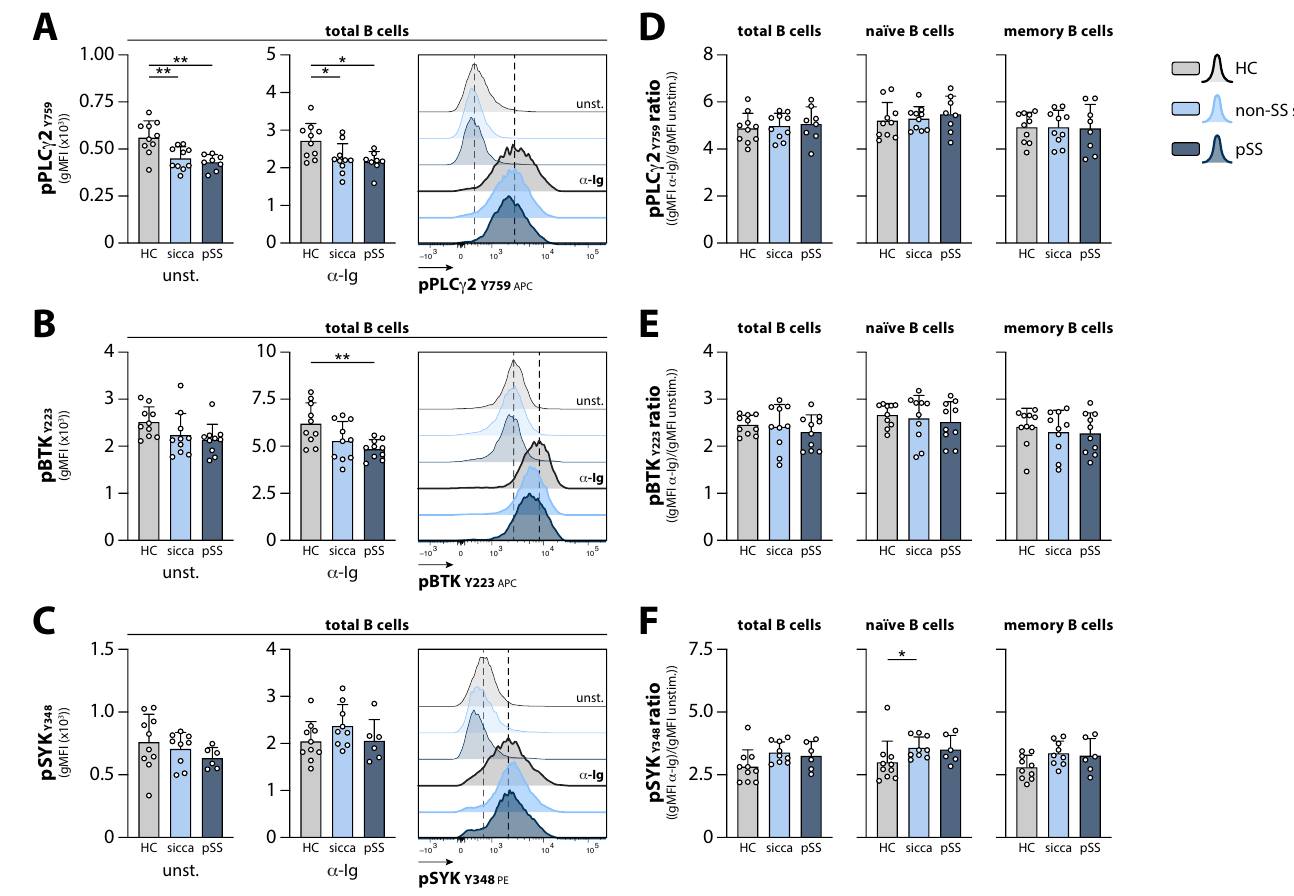
Figure 3. B cell receptor signaling responsiveness in circulating B cell subsets from non-SS sicca patients, pSS patients, and HCs. ( A – C ) Phosphorylation of ( A ) PLC γ 2 (Y759), ( B ) BTK (Y223), and ( C ) SYK (Y348) in unstimulated (unst.) and α -Ig stimulated circulating total B cells. Representative histograms are shown. ( D – F ) The stimulation ratio for ( D ) pPLC γ 2 (Y759), ( E) pBTK (Y223), and ( F ) pSYK (Y348), as determined by dividing the phosphorylation signal from the α -Ig stimulated condition by the phosphorylation signal at the unstimulated condition. Data shown for total, naïve, and memory B cells. Bars indicate mean + SD. ** p < 0.01 and * p < 0.05 by Kruskal–Wallis test with Dunn’s correction for multiple